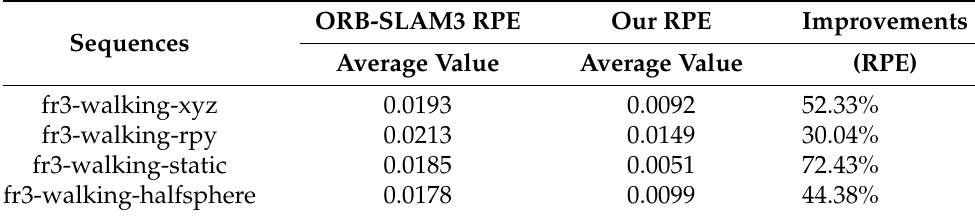
Table 5. Percentage of Average RPE